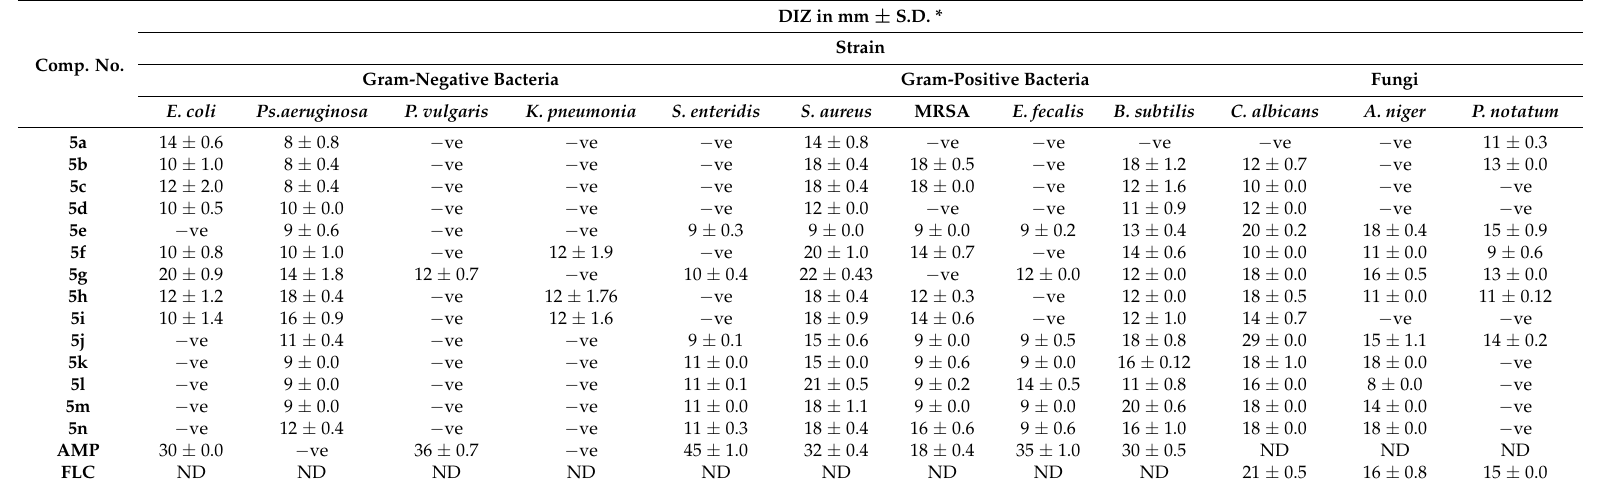
Table 1. Diameter of the inhibition zone (DIZ) of the title compounds 5a – n , ampicillin (AMP) and fluconazole (FLC) toward Gram-negative and -positive bacteria and